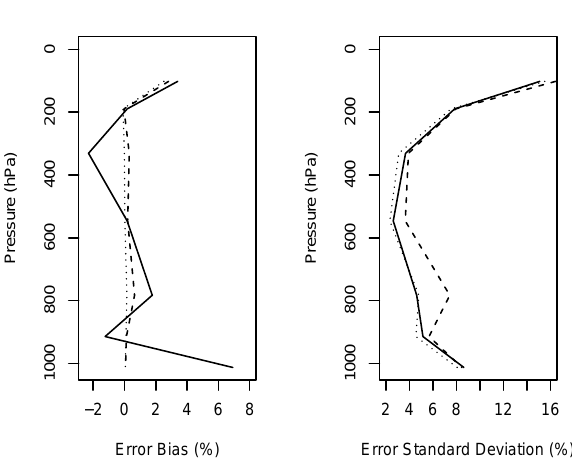
Figure 3. Vertical profiles of R (left), biases (center, in %RH) and SD (right, in %RH) for the MLP (solid line), the GAM (dashed line) and the LS-SVM (dotted line) models, trained on noise-free SAPHIR and MADRAS